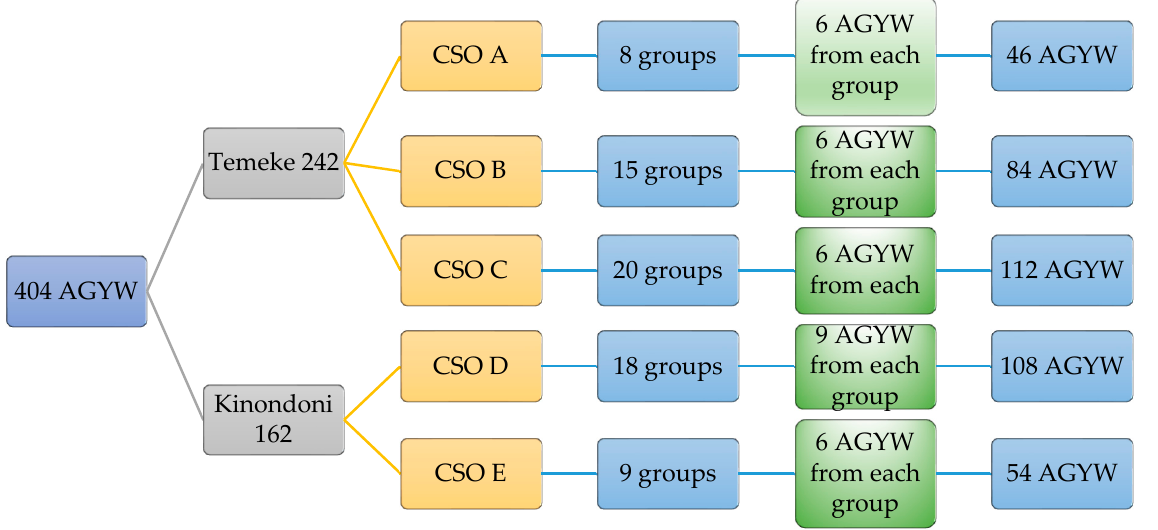
Figure 1. Proportionate sampling tree for AGYW participants